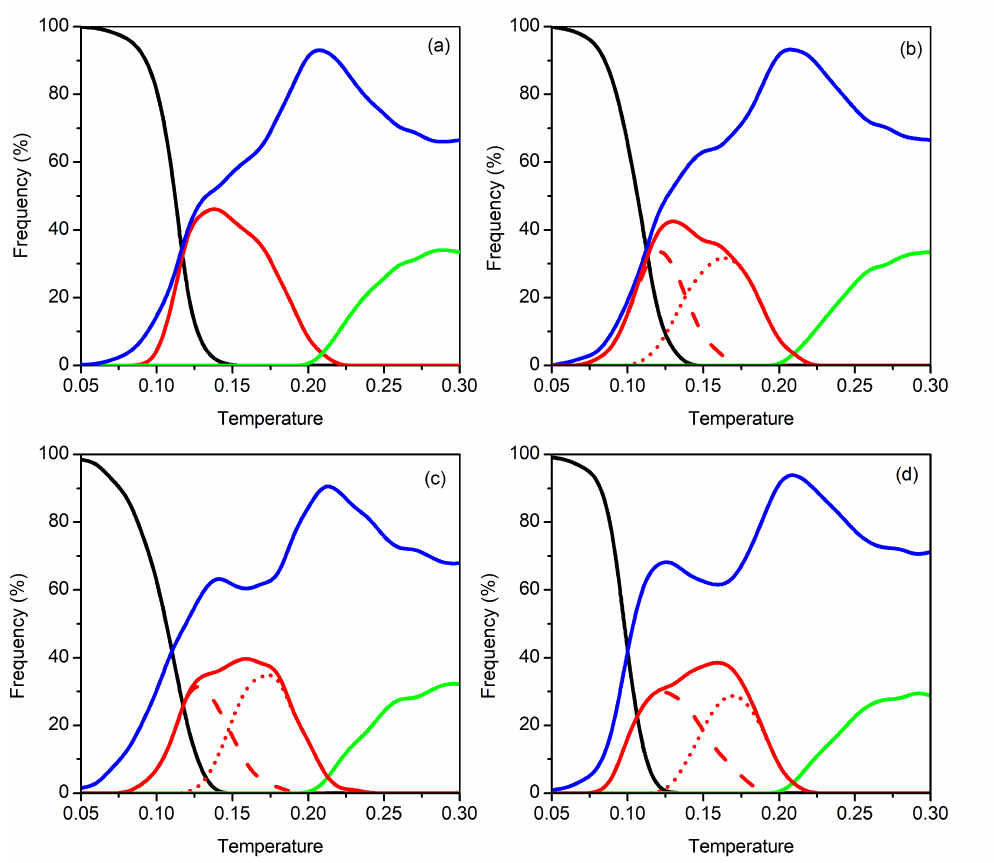
Figure 7. Frequency of the structural motifs as a function of temperature: ( a ) N = 17; ( b ) N = 18; ( c ) N = 19; ( d ) N = 20. Besides low-frequency miscellaneous motifs (blue), lines corresponding to other sets of structures, as defined in Figure 6, are also indicated: Set I (black); Set II (red); Set III (green). For N = 18 − 20, red dashed and red dotted lines correspond, respectively, to structures from Set IIa and Set IIb (see Figure